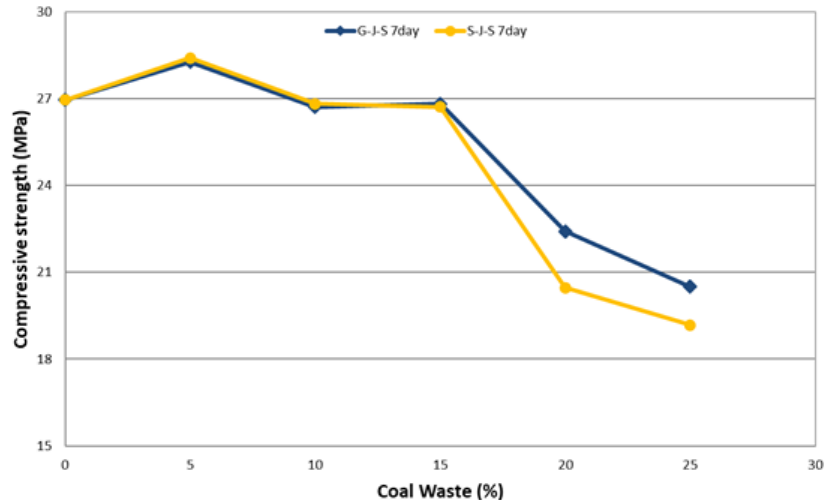
Figure 8. Effect of type and amount of coal waste on the compressive strength after 7 days .